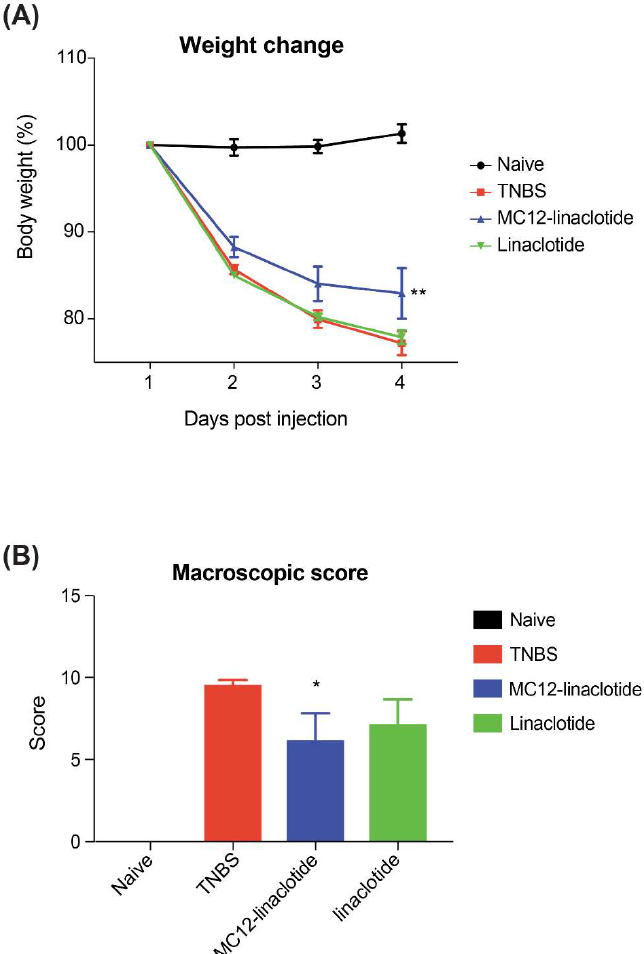
Figure 4. Protective effects of MC12-linaclotide against colitic weight loss and macroscopic pathology induced by intra-rectal administration of TNBS. Mice (5 per group) were untreated (naïve) or treated with TNBS following intra-peritoneal administration of peptides (3 mg/kg) or saline vehicle control (TNBS). ( A ) Percentage weight change (** p = 0.0018); ( B ) Macroscopic pathology score (* p = 0.0238). Data was analysed using GraphPad Prism. Statistical analyses of weights were performed using the two-way ANOVA, with multiple comparisons of the groups over different days. Macroscopic score was analysed using unpaired Mann-Whitney non-parametric tests. All values are expressed as mean ± SEM. Results were considered significant when p <